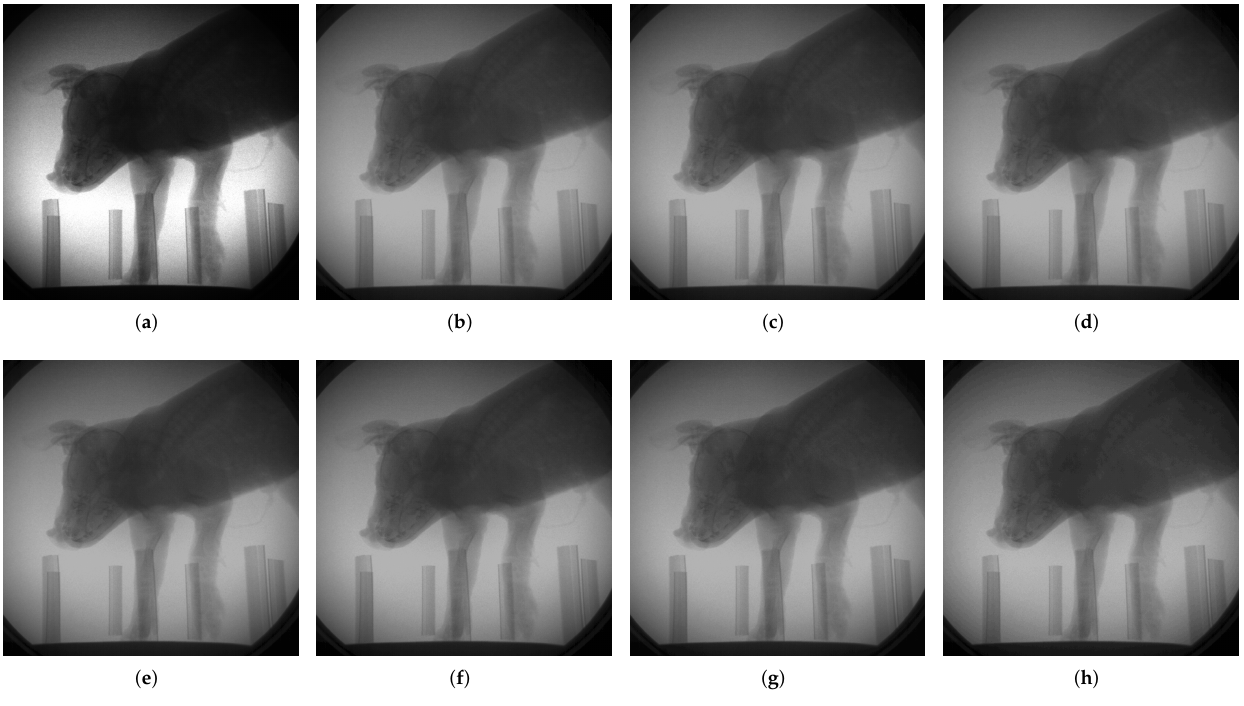
Figure 5. Contrast Enhancement. ( a ) Figure, ( b ) accurate, ( c ) ASC-SR with p 4, ( d ) ASC-HR with p 4, ( e ) ASC-SR with p 6, ( f ) ASC-HR with p 6, ( g ) ASC-SR with p 8, ( h ) ASC-HR with p